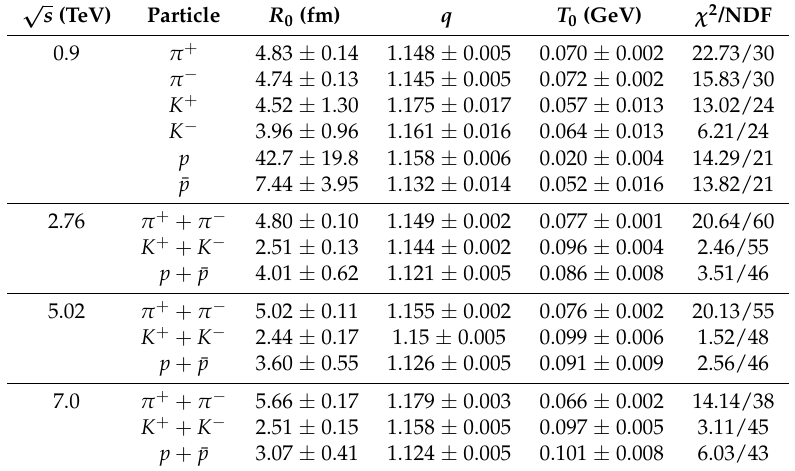
√ s = 0.9 [19], 2.76 [20], 5.02 [21] and 7 TeV [21,22], using data from the ALICE Table 1. Fit results at Collaboration using Equations (6) and (7).